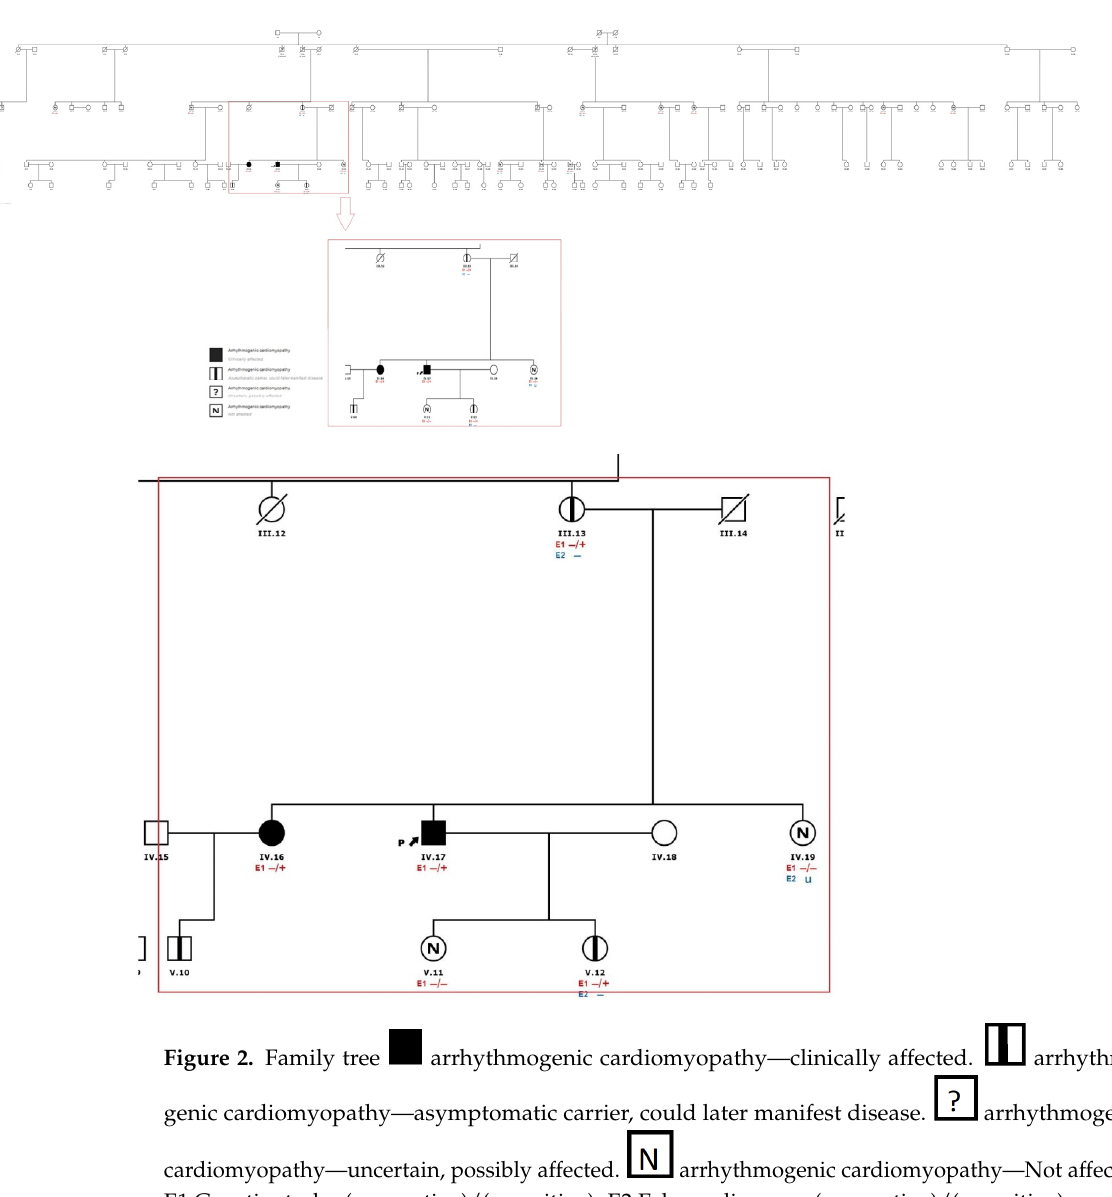
Figure 2. Family tree arrhythmogenic cardiomyopathy—clinically affected.